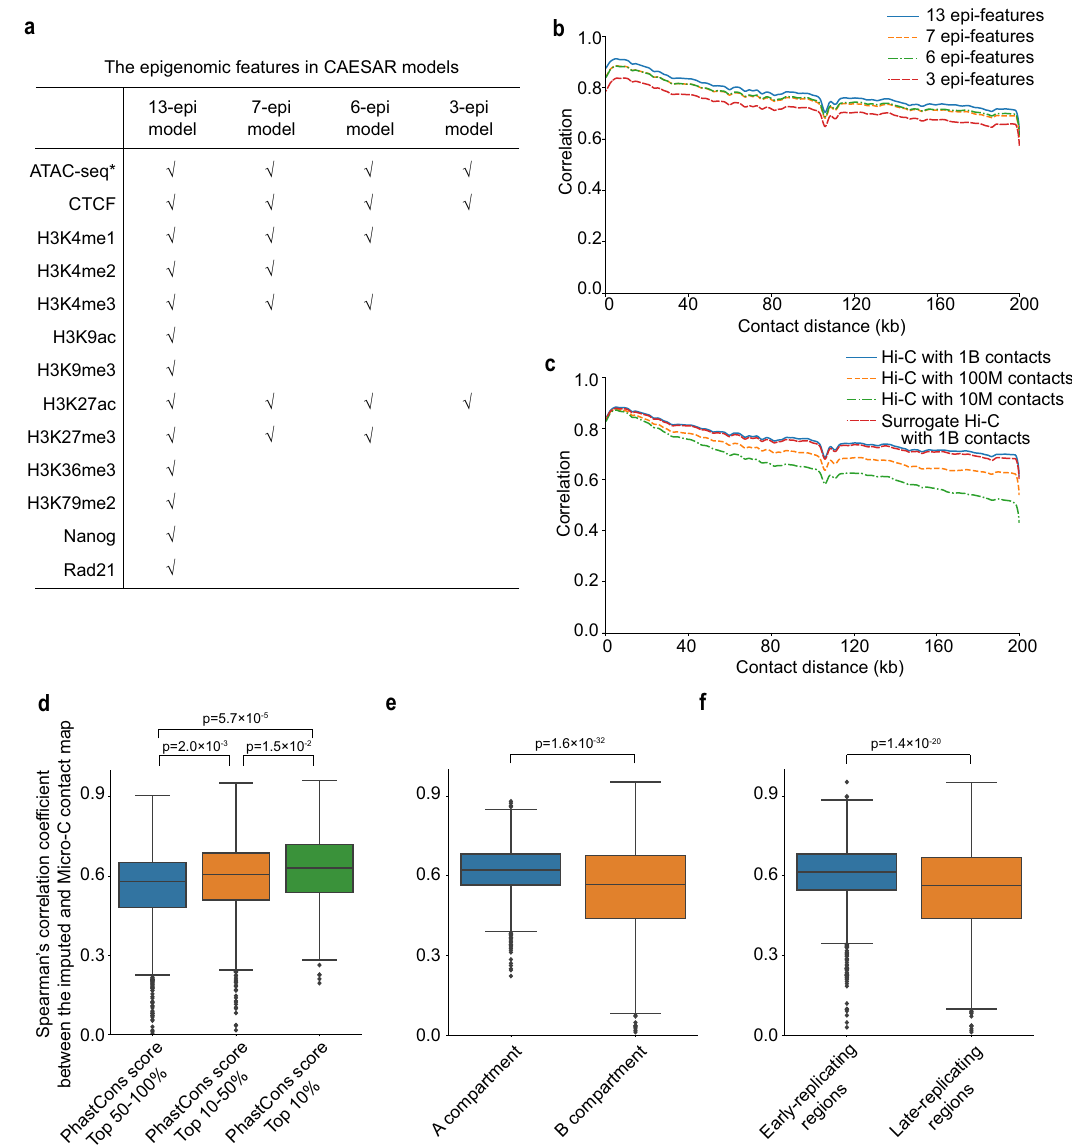
Fig. 3 The relationships between CAESAR ’ s performance with Hi-C quality, the number of epigenomic features, evolutionary conservation, A/B compartments, and early/late replication timing. a The epigenomic features in 13-epi, 7-epi, 6-epi, and 3-epi CAESAR models are listed in the table, which are chosen based on common availability. b The distance-strati fi ed Pearson ’ s correlation with the observed Micro-C contact map from CAESAR in a cross- cell-type experiment with different numbers of epigenomic features (i.e., 13, 7, 6, and 3). c The distance-strati fi ed Pearson ’ s correlation with the observed Micro-C contact map from CAESAR in a cross-cell-type experiment when (1) using the original Hi-C contact map with about 1 billion contacts, (2) randomly downsampling the Hi-C contact map at different downsampling rates (resulting in 100 million and 10 million chromatin contacts), and (3) using a surrogate Hi-C contact map with 1 billion contacts aggregated from HFF, GM12878, IMR-90, and K562 with equal proportions. d The model performance in a speci fi c region is quanti fi ed by Spearman ’ s correlation coef fi cient between the CAESAR-imputed and the Micro-C contact map. In cross-chromosome and cross-cell-type experiments, the model performance (i.e., Spearman ’ s correlation coef fi cient) is signi fi cantly correlated with evolutionary conservation evaluated by sequence alignment scores (n[regions] = 1203, 960, and 240, one-sided t test). In all the boxplots, the center line indicates median; the box limits are upper and lower quartiles; the whiskers are 1.5 × interquartile range; the points are outliers. e In cross-chromosome and cross-cell-type experiments, the correlation coef fi cient is signi fi cantly larger in A compartment than in B compartment (n[regions] = 1,018 and 1,388, one-sided t test). f In cross-chromosome and cross-cell-type experiments, the correlation coef fi cient is signi fi cantly larger in early-replicating regions than in late-replicating regions (n[regions] = 1205 and 1109, one-sided t test). both locate in chr16:57,950,000 – 58,050,000. The loop between the line. Previous works 20 have shown eQTLs are enriched in tissue- pancreas-speci fi c eQTL and its target USB1 gene can only be speci fi c frequently interacting regions on Hi-C contact maps at 40 called from the CAESAR-imputed contact maps of the pancreas. kb resolution, but a large portion of eQTLs reside too close to their The loop between lung-speci fi c eQTL and its target TEPP gene can gene transcriptional start sites (TSS) to be seen on a low-resolution be called from the CAESAR-imputed contact maps of both lung contact map (Fig. 5a and Supplementary Fig. 7a). For example, and pancreas, which demonstrates some tissue-speci fi c eQTLs do two eQTLs that are speci fi c in the pancreas and lung, respectively, NATURE COMMUNICATIONS| (2022) 13:2054